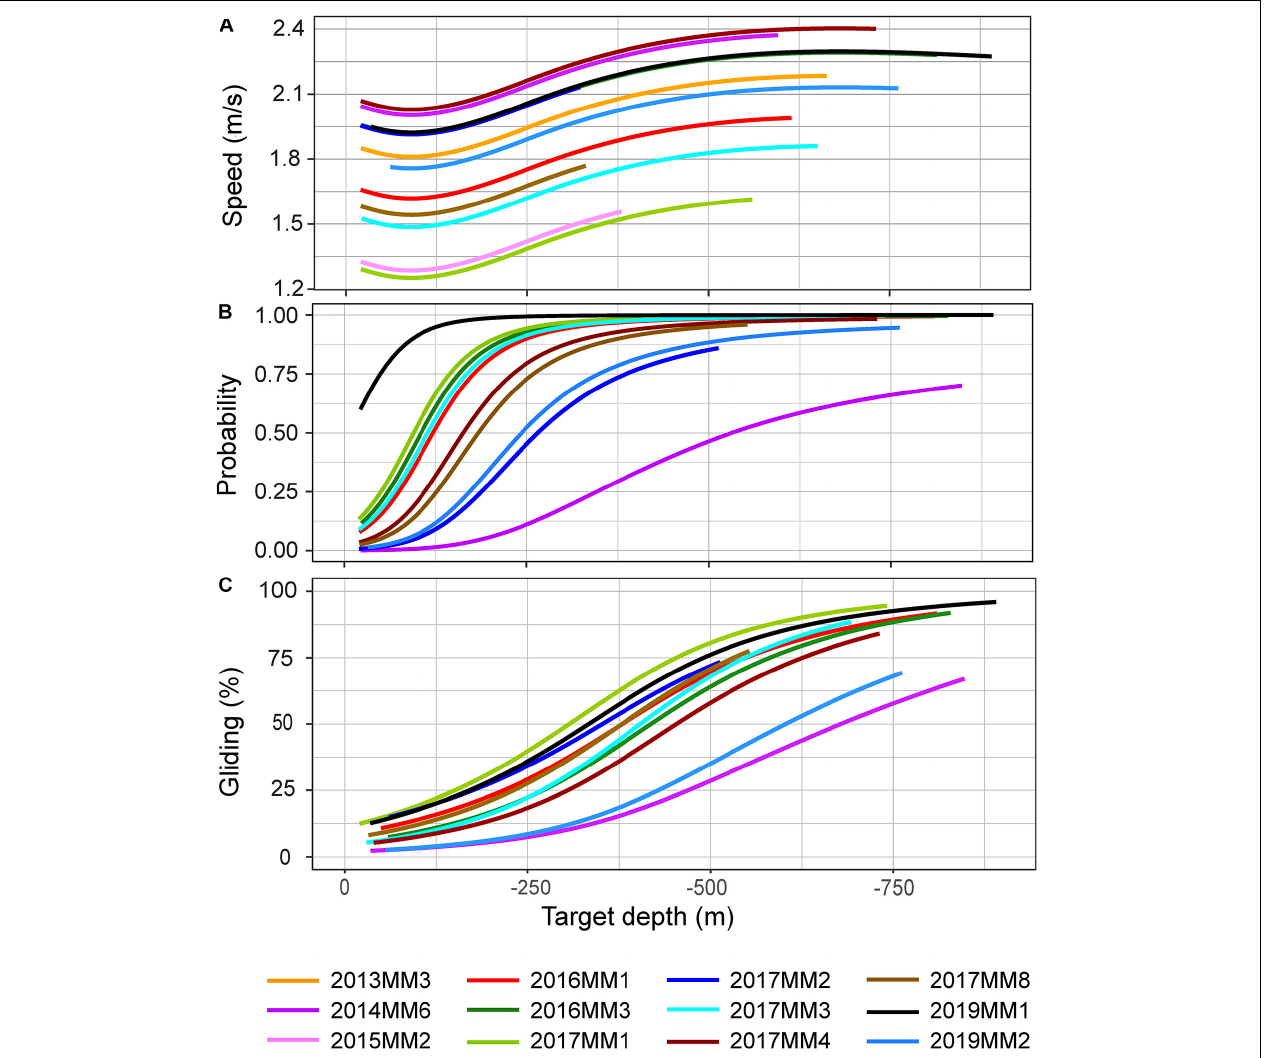
FIGURE 5 | Model outputs for median speed during the first 100 m of a descent (A) , probability for gliding during descent (B) and percentage of time spent gliding during descent (C) in relation to target depth of a dive. All individuals were included in A, apart from 2014MM5 due to small amount of data ( < 1h). Animals with high resolution acceleration data, apart from 2014MM5, were included in B and C (see Table 2 ). The depth range of the model projections reflects the depth range of observations for each